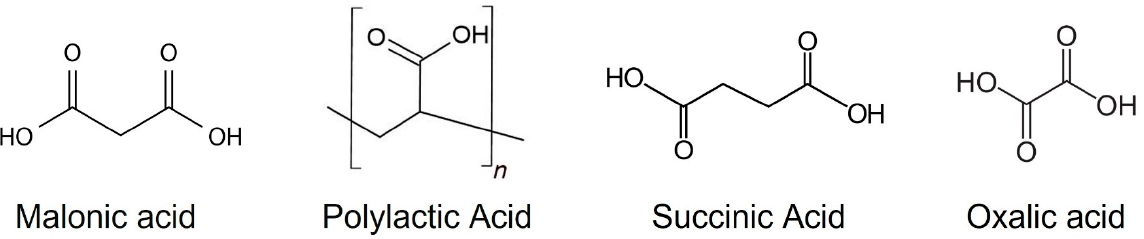
Figure 2. Chemical formulae of the organic acids used in this study.